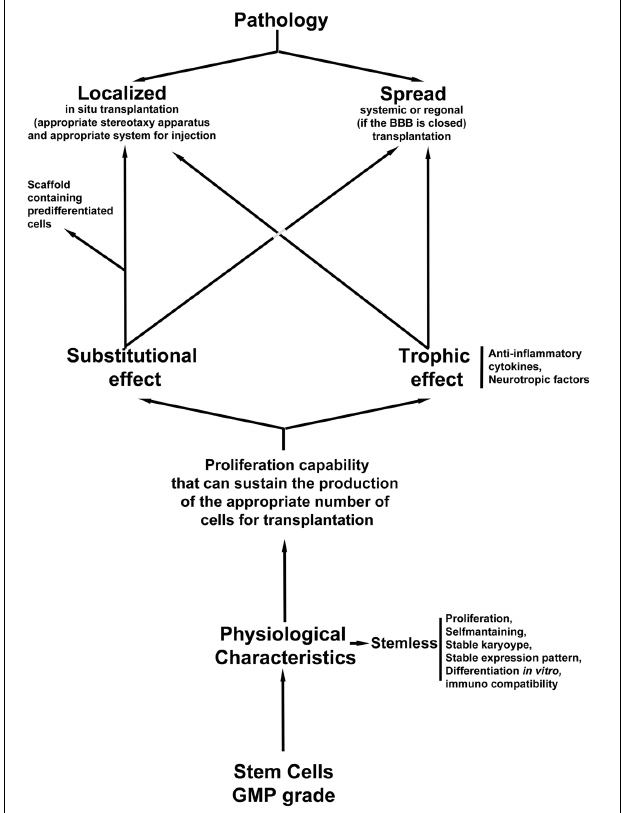
FIGURE 1 | Flow chart of the appropriate decisions for the choice of stem cells and the method of